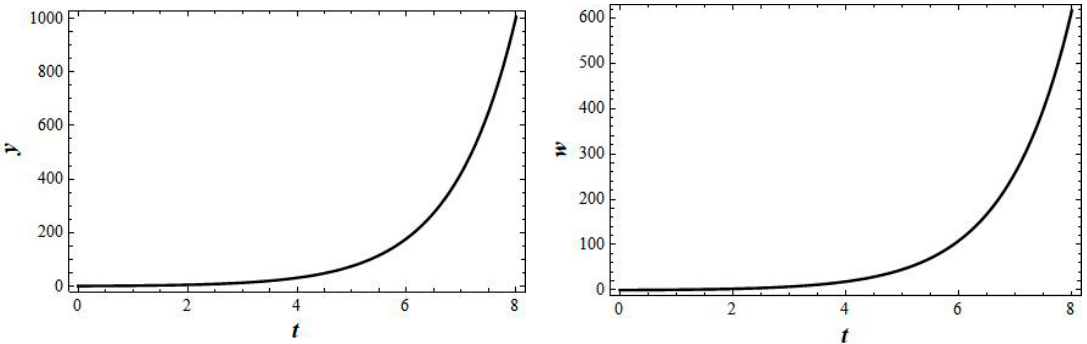
Figure A4. Exact solutions of system (2) when b 1 = 2.266, b 2 = 1, b 3 = 2.092, b 4 = 2, k = 1, c 1 = 1, ac ‐ cording to Formula (16).